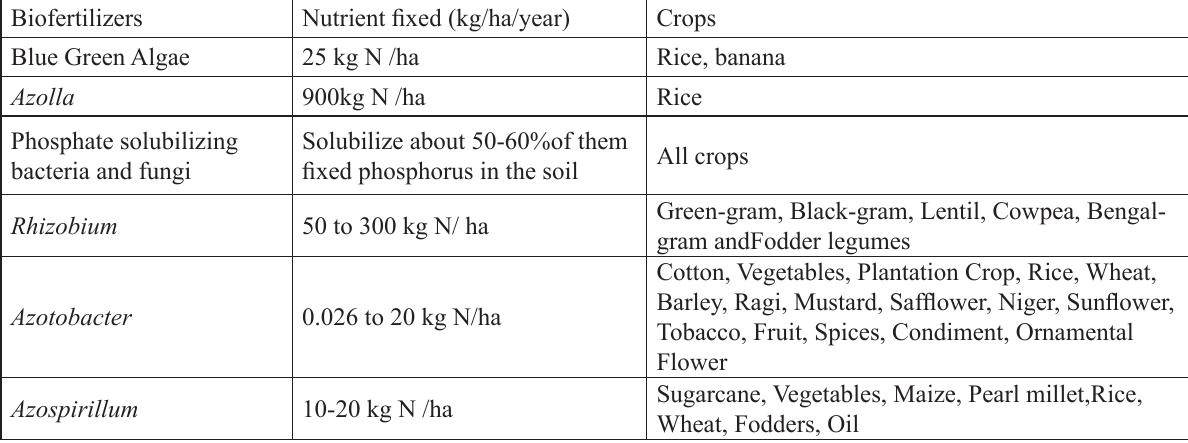
Table 2: Amount of nutrients fixed in soil by biofertilizers in crops